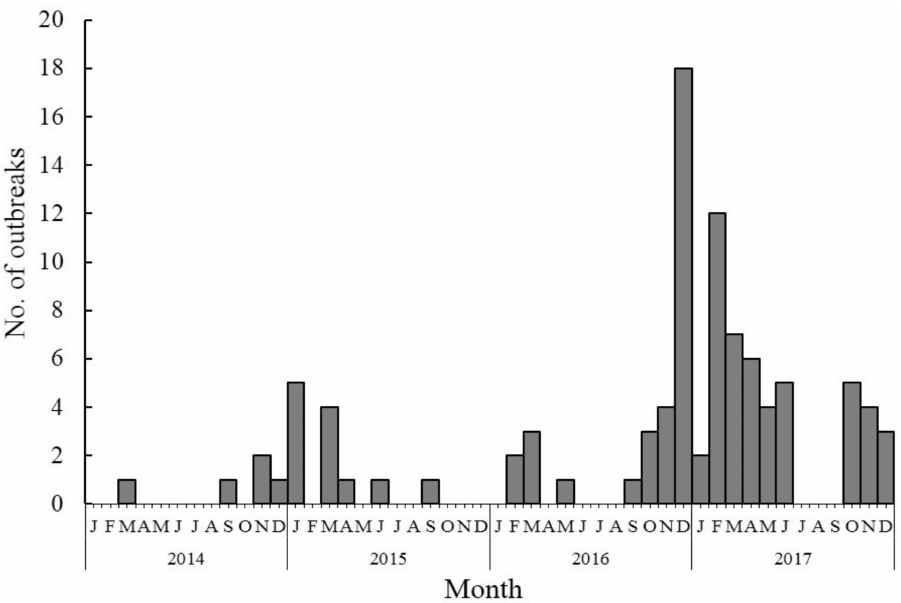
Figure 2. Number of reported norovirus outbreaks by month in China,